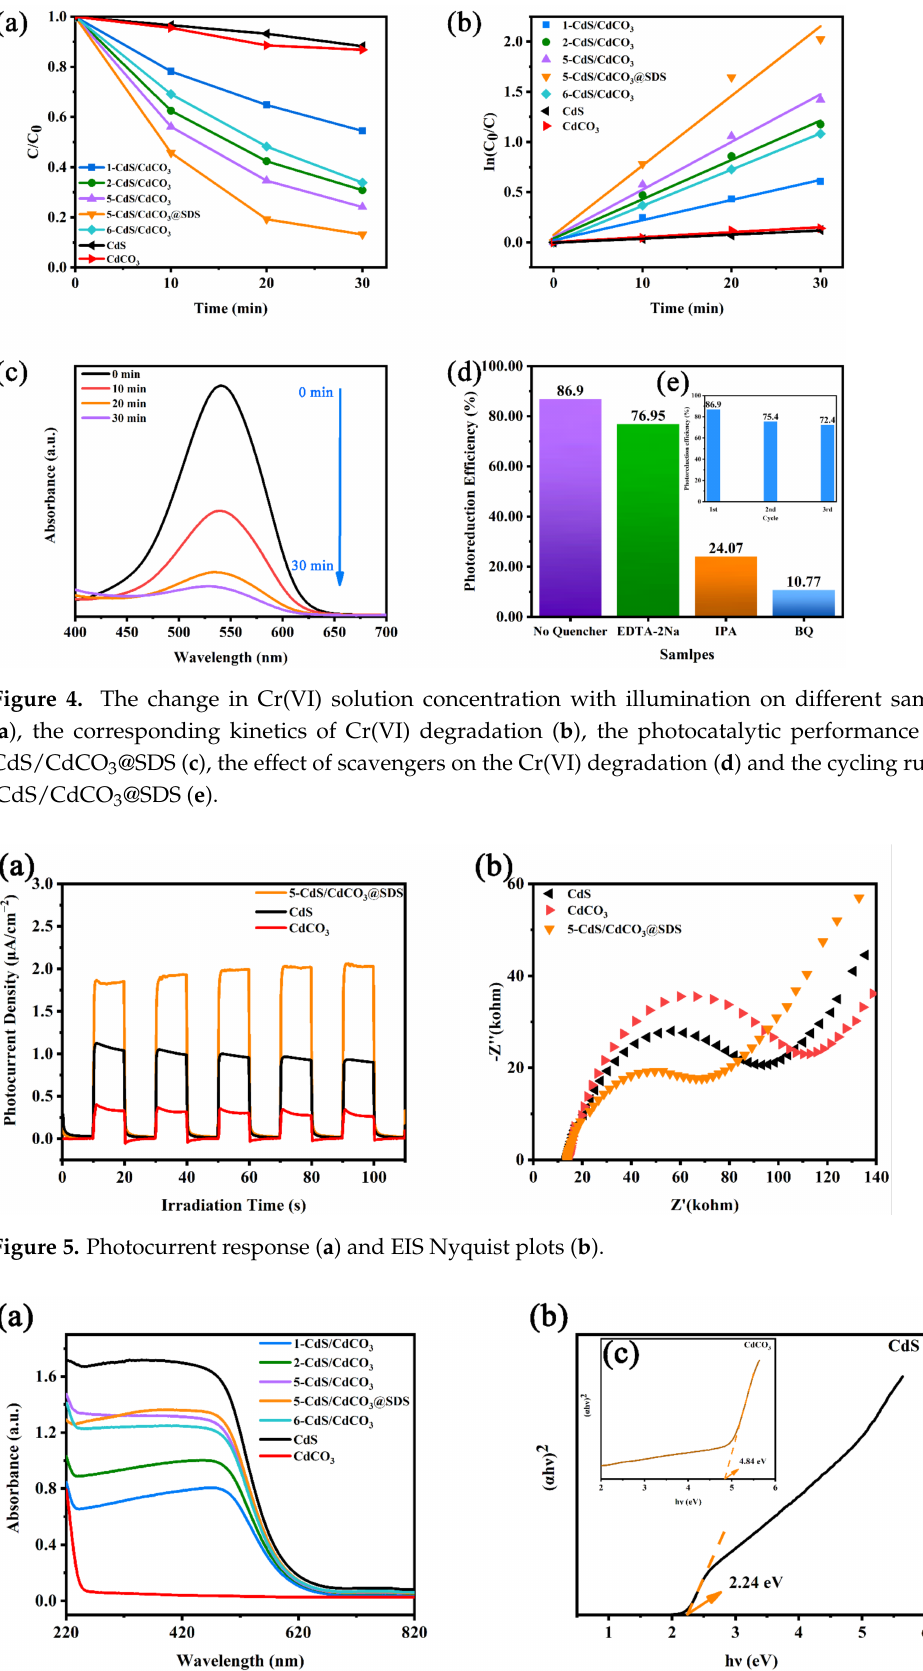
Figure 6. DRS spectra ( a ) and the band energy of as-synthesized photocatalysts ( b , c